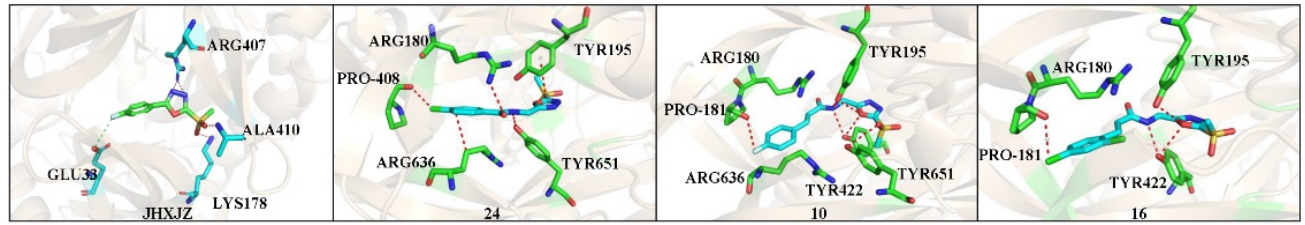
Figure 3. The binding modes of JHXJZ and compounds 24 , 10 , and 16 .